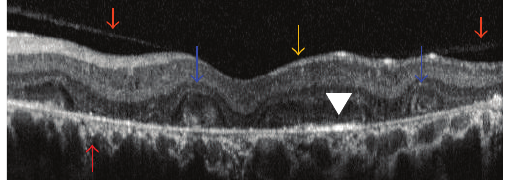
Figure 3: Case 1, left eye. Transverse OCT section showing the asso- ciated vitreomacular adhesion (orange arrows) besides outer reti- nal tubulations (blue arrows), choroidal hyperreflective spots (red arrow), and bright reflective spots on top of RPE-Bruch membrane complex (white